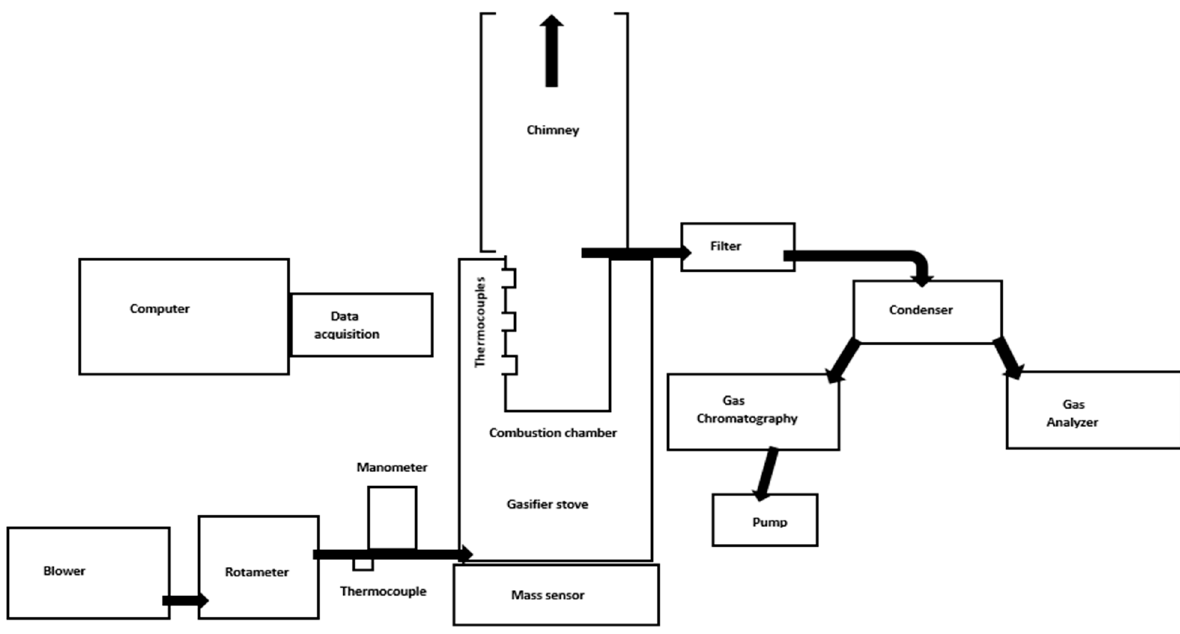
Figure 1. Experimental setup.